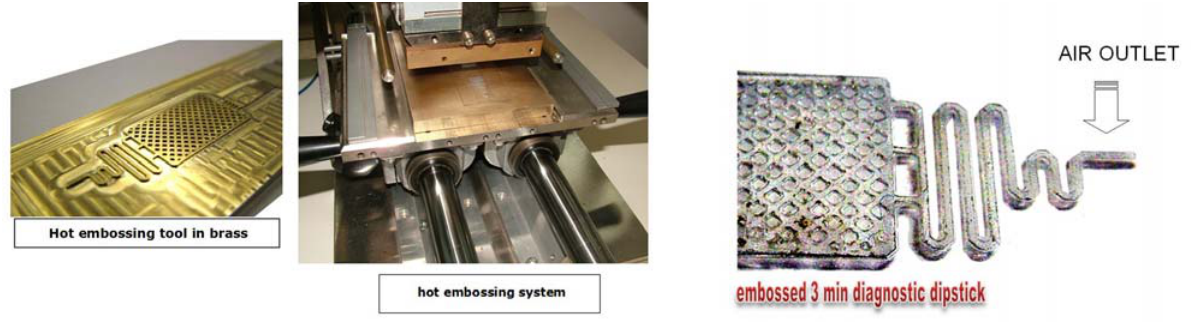
Figure 3. Hot embossing unit, tool and hot embossed air outlet structure to prevent leakage of fluid from the